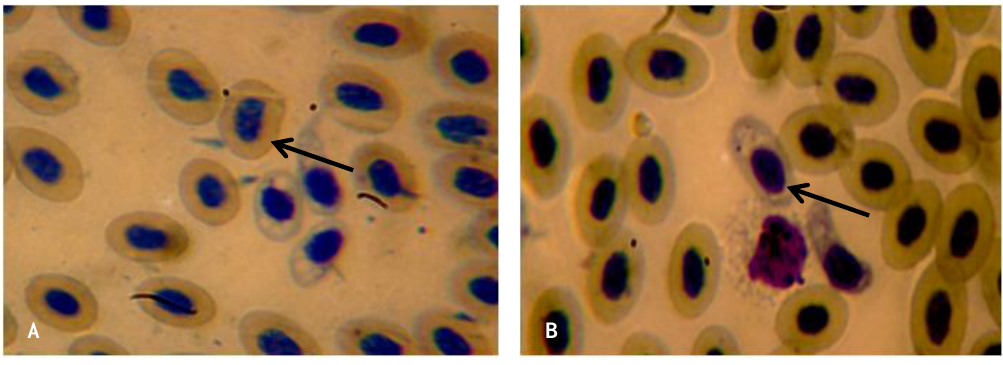
Figure 1; A and B: Chickens blood smears showing Plasmodium spp.